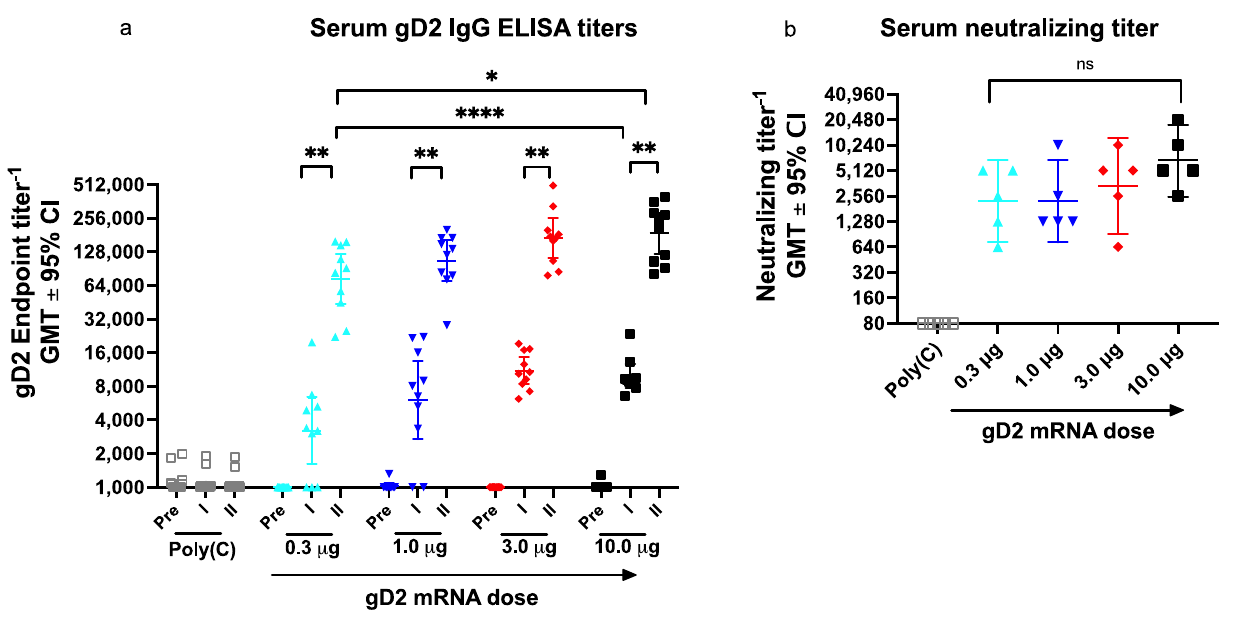
Figure 2. gD2 mRNA-LNP generates serum IgG ELISA and neutralizing antibody responses in a dose- dependent pattern. ( a ) Serum gD2 IgG ELISA titers were evaluated prior to the first immunization and four weeks after the first and second immunization ( n = 10 sera/dose) (pre and prior to the first immunization; I and II, sera obtained after the first and second immunizations, respectively). ( b ) Neutralizing antibody titers were determined in the presence of complement ( n = 5 sera/dose). p values comparing ELISA IgG titers after the first and second bleeds were calculated by the Wilcoxon matched pairs signed rank test. p values comparing different doses in ( a , b ) were calculated by the two-tailed Mann–Whitney test. p value in ( a ) comparing 10.0 µ g with 0.3 µ g was